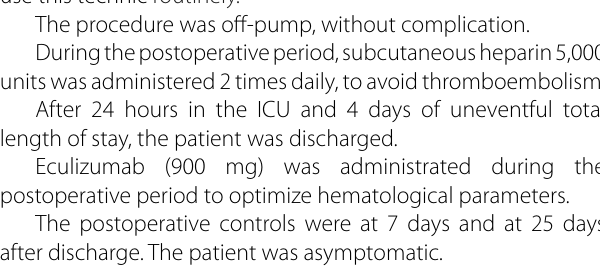
Fig. 1 – Coronary Angiotomography.